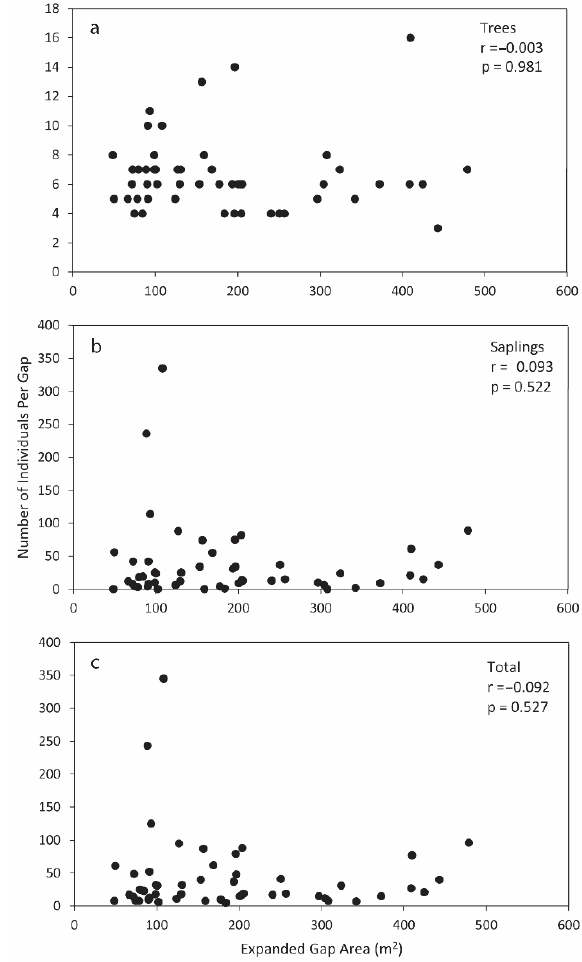
Figure 2. Pearson correlation between expanded gap area and the number of stems for ( a ) trees (live stems ≥ 10 cm dbh), ( b ) saplings (live woody stems ≥ 1 m height, <10 cm dbh), and ( c ) total stems (trees and saplings) in a montane Pinus palustris woodland. Note that the y -axis varies. Out of the 50 canopy gaps sampled, 41 were confidently dated to a formation year.